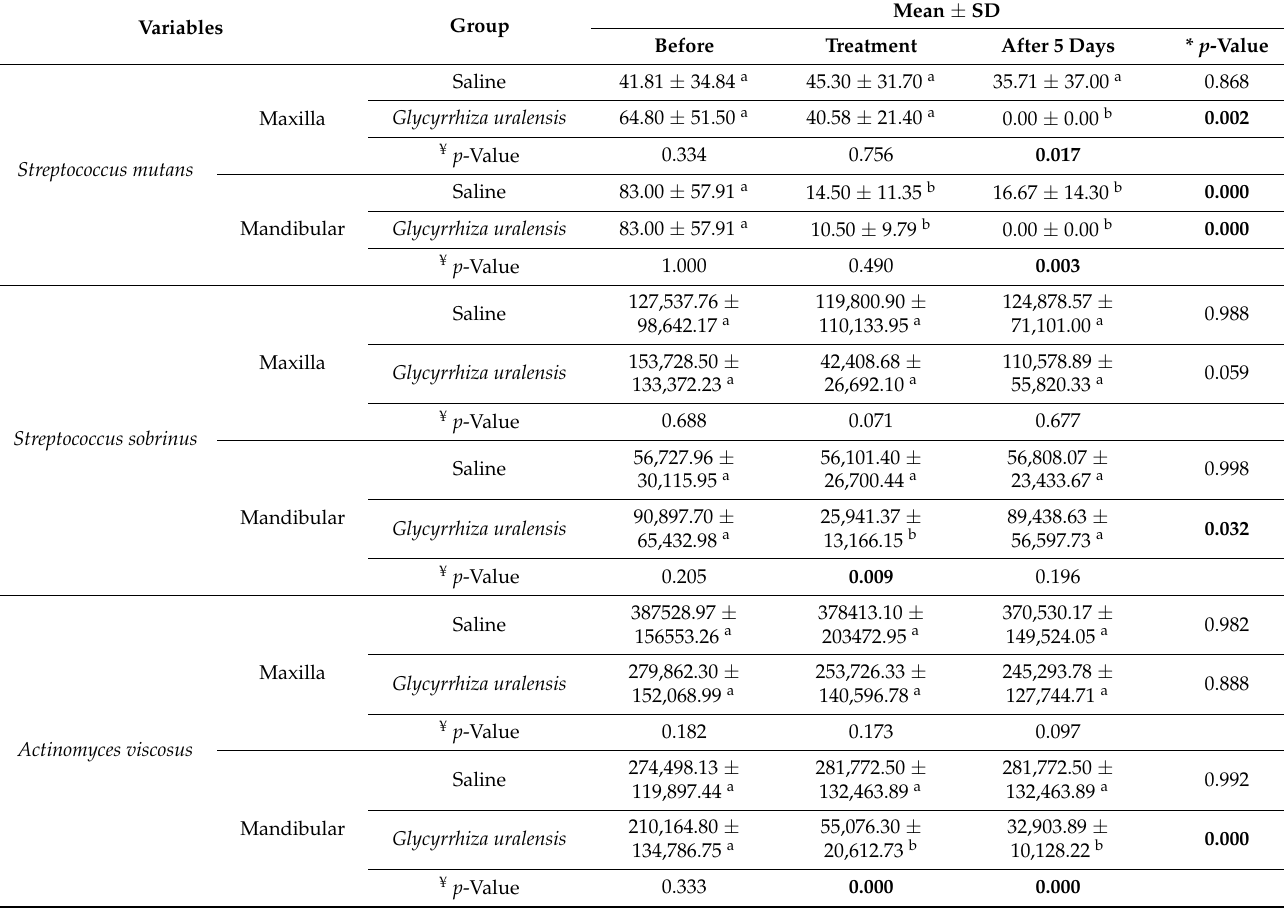
Table 6. Clinical outcomes were observed between the